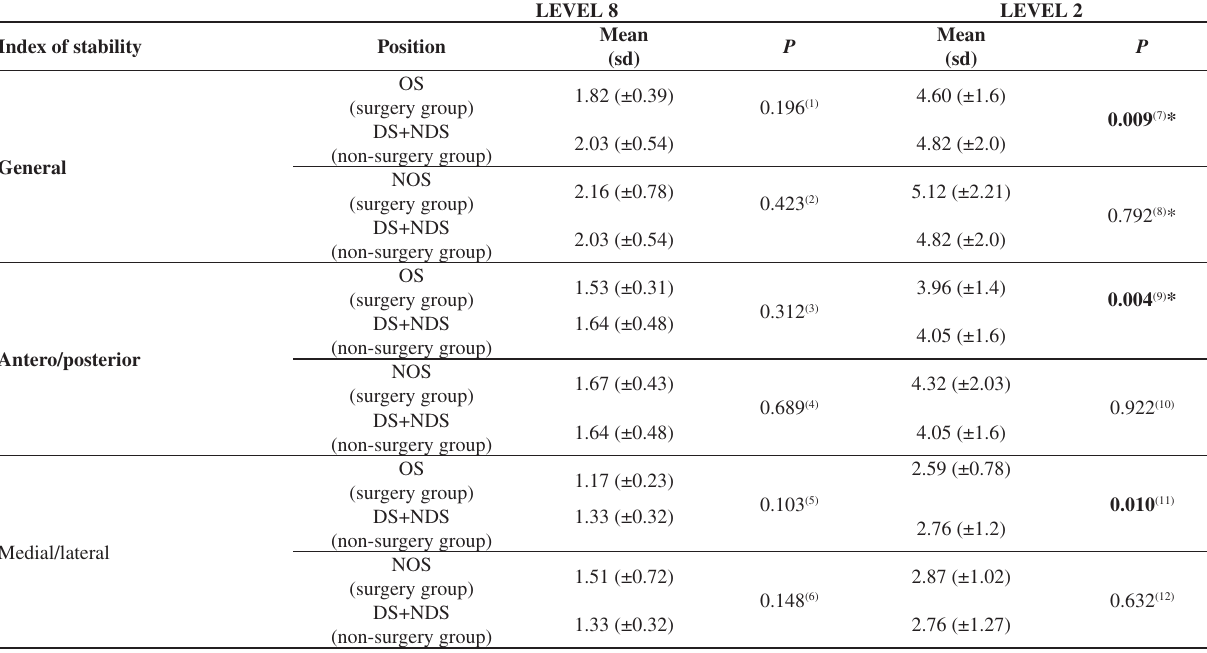
Table 2 - Intergroup comparison of the center of gravity dislocation and postural balance of the Surgery Group (OS and NOS) versus the Non-surgery group (DS and NDS) at stability levels 8 and 2